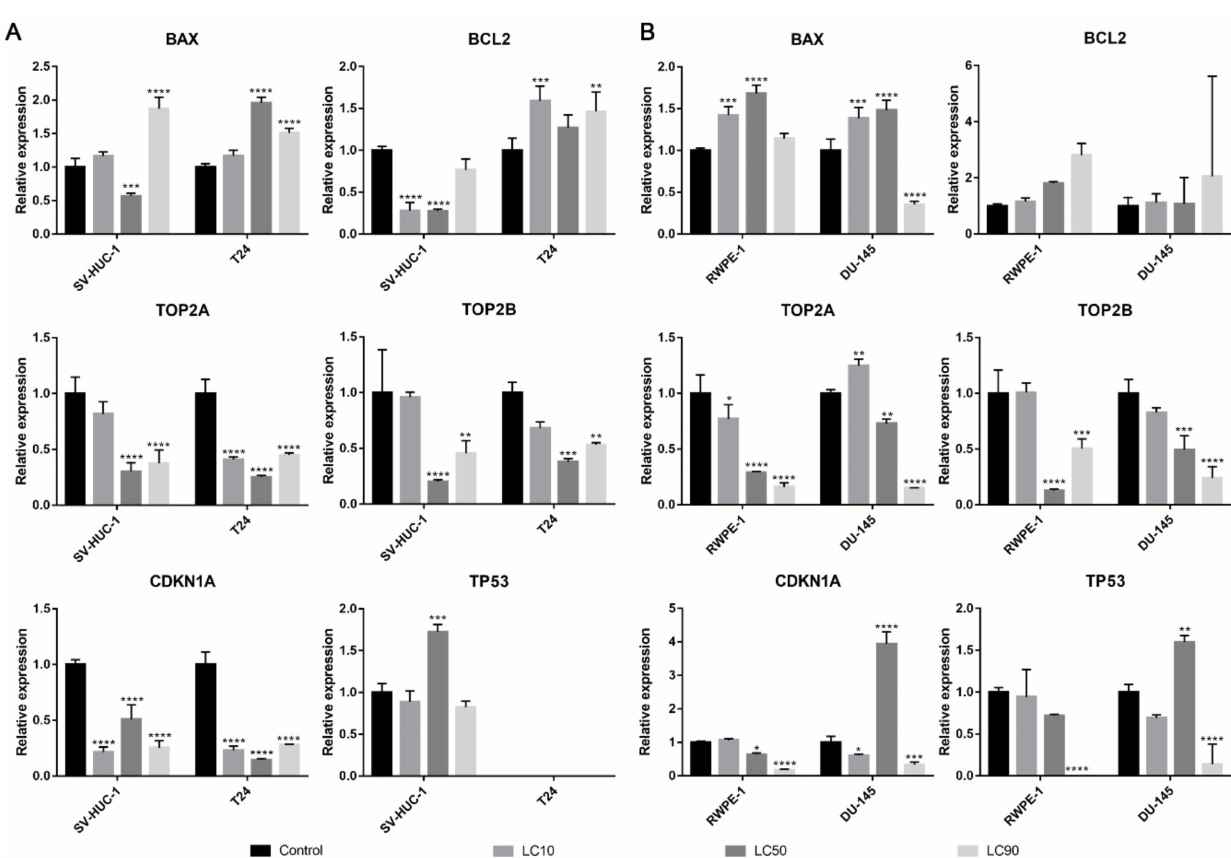
Figure 6. Molecular analysis of gene expression in bladder and prostate cell lines following incubation with ciprofloxacin. Experiment was performed using LC values of ciprofloxacin obtained after 24 h incubation. Relative gene expression of control was calculated as 1. ( A )—Bladder cell lines. ( B )—Prostate cell lines. SV-HUC-1—non-malignant human urothelium; T24—human bladder cancer; DU-145—human prostate cancer; RWPE-1—non-malignant human prostate epithelium. Statistically significant results compared to control were presented: *— p ≤ 0.05; **— p ≤ 0.01; ***— p ≤ 0.001; ****— p ≤